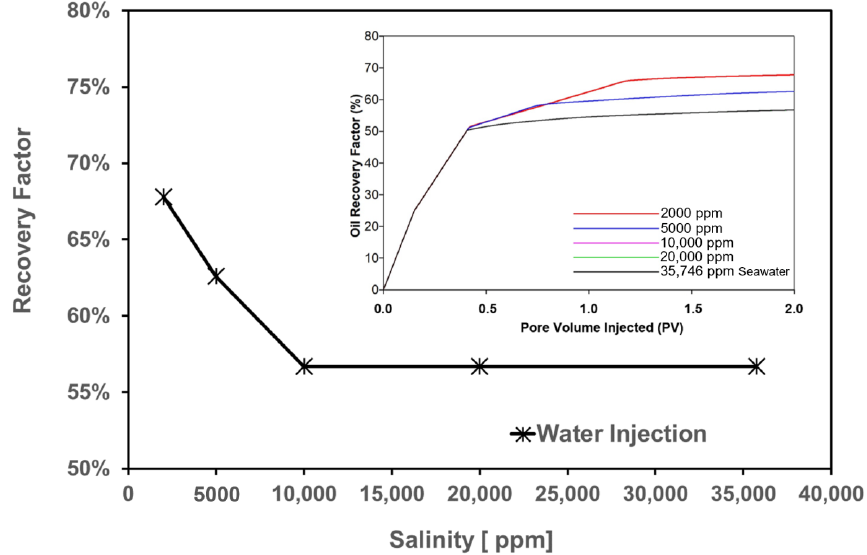
Figure 20. Oil recovery by water injection with varying